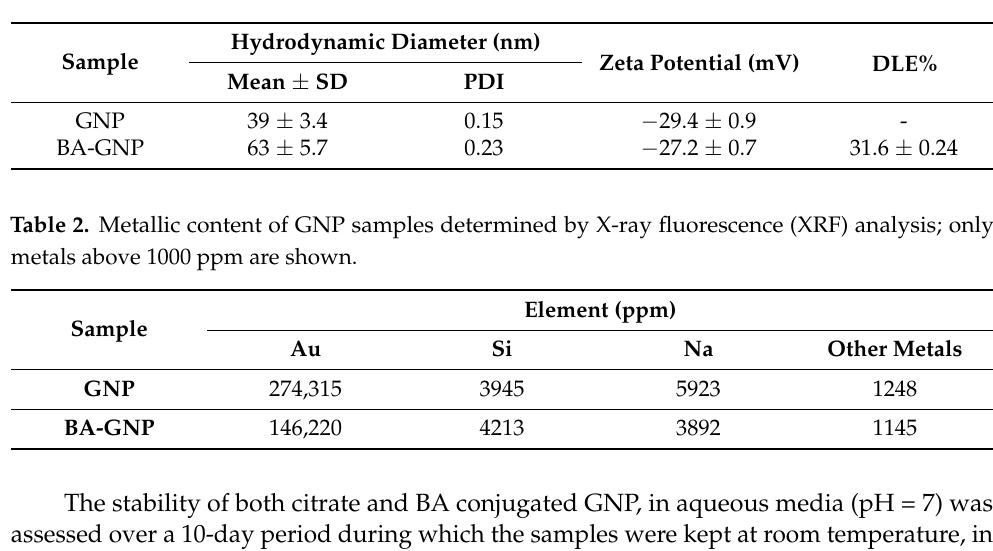
Figure 4. TEM images of GNP ( A ) and BA-GNP ( B ). Table 1. Recorded hydrodynamic diameter, ζ potential and drug loading efficiency (DLE) for GNP and BA-GNP.